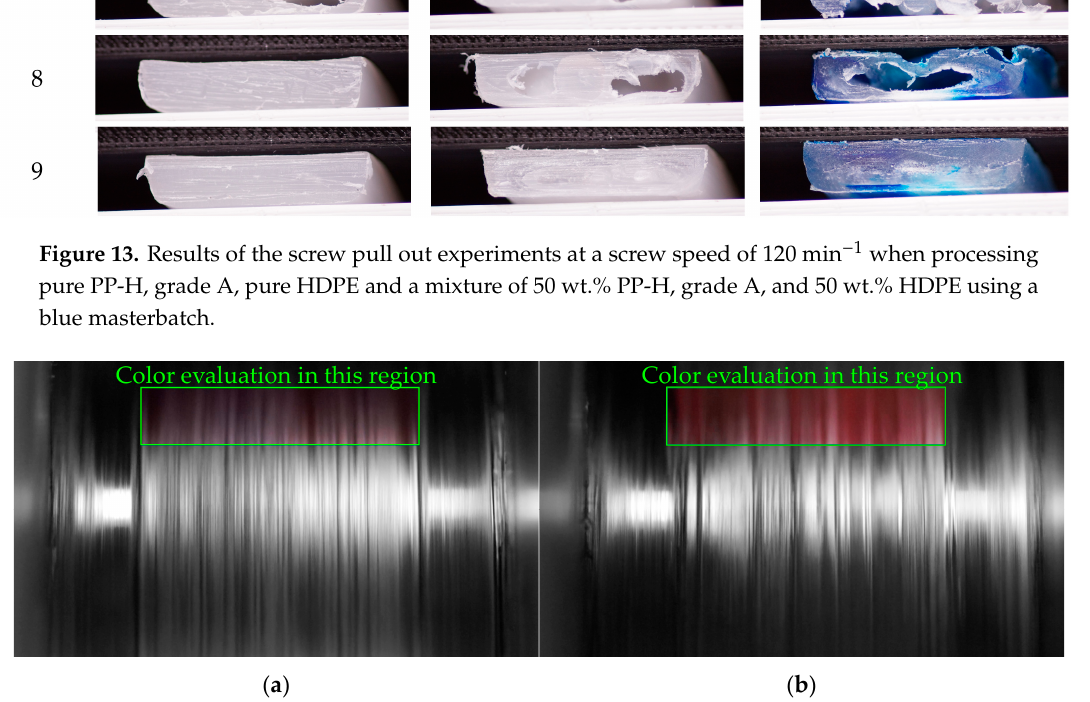
Figure 14 . Typical pictures (frames of the video file) captured during melting experiments of two pure polymers. The rectangular shows the analyzed region. The color outside of the analyzed region is not analyzed and greyed out in these depictions. ( a ) Pure blue PP-H, grade B; ( b ) pure red HDPE.